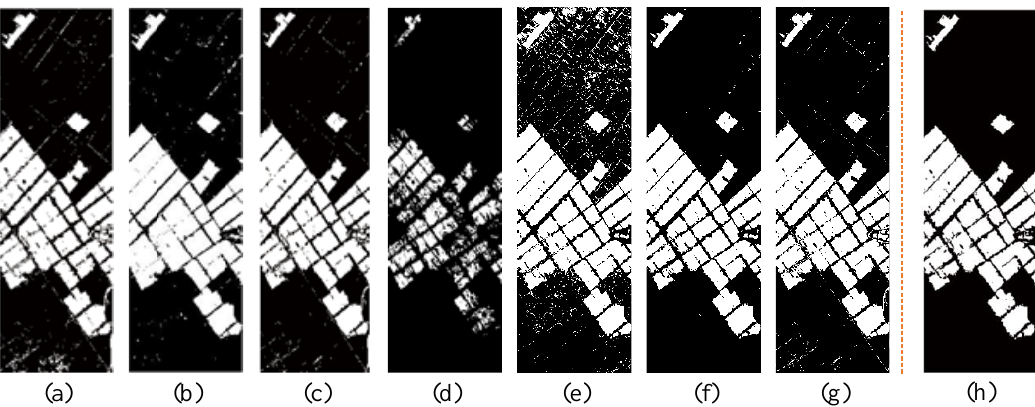
Figure 6. The change detection maps of different methods for the dataset of farmland, ( a ) the change detection map of CVA, ( b ) PCA-CVA, ( c ) IR-MAD, ( d ) SVM, ( e ) CNN ( f ) GETNET, ( g ) our method, and ( h ) ground-truth map.